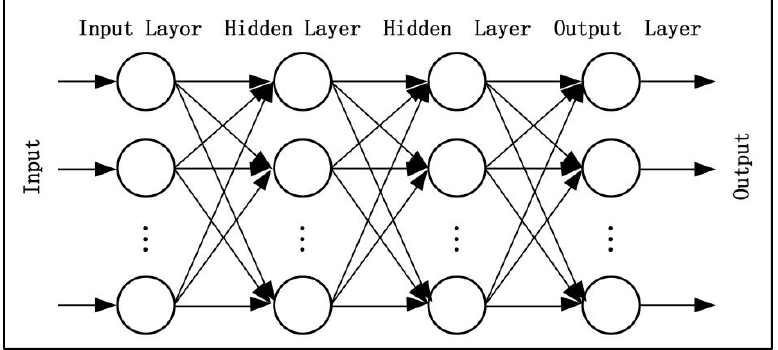
Figure 4. Multi-layer perceptron network structure diagram.